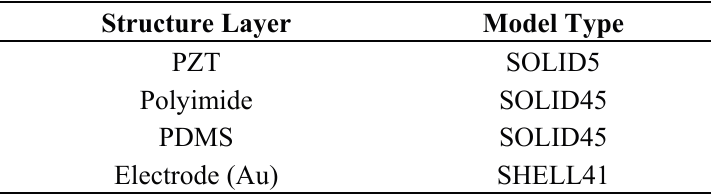
Table 2. Finite element model of the type used in ansys.